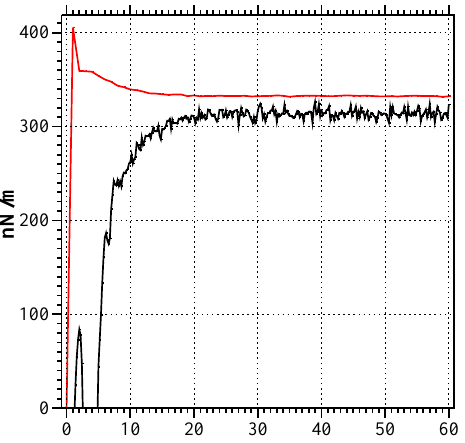
Figure 3. Thrust history in ν = 0 . 12 run: method Mom (black) and method Coul